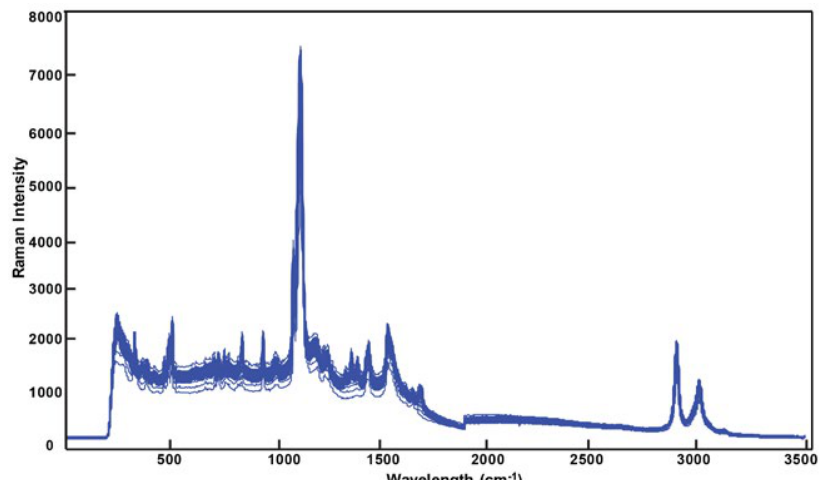
Figure 2 . A series of Raman spectra recorded of a Suzuki cross-coupling reaction that was conducted at reaction temperature of 65